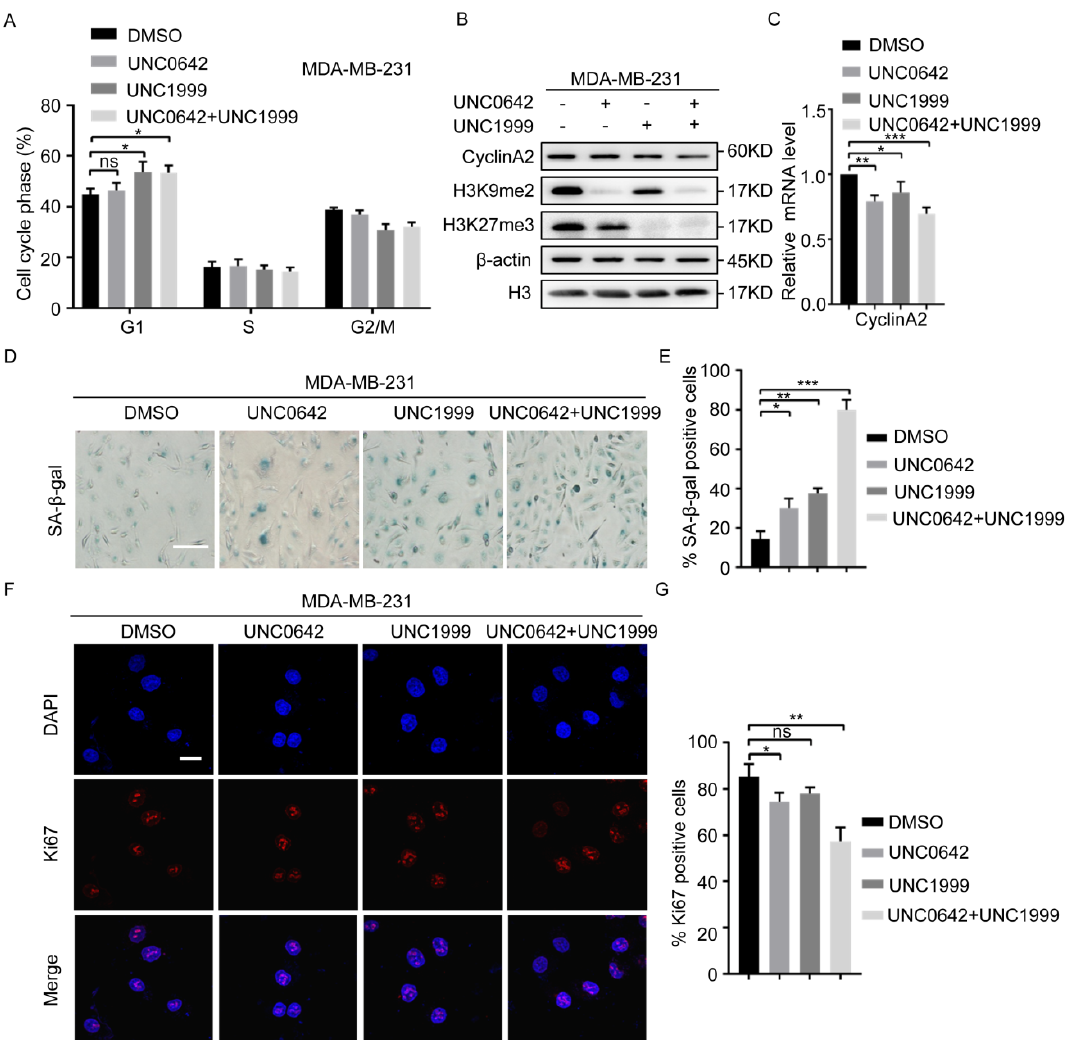
Figure 2. A combination of UNC0642 and UNC1999 induces MDA-MB-231 cellular senescence. ( A ) Cell cycle analysis in MDA-MB-231 cell treated with indicated treatments. ( B ) Western blot analysis of expression of CyclinA2, H3K9me2, and H3K27me3 in MDA-MB-231 cells treated with indicated treatments. ( C ) qRT-PCR analysis of the expression of CyclinA2 in MDA-MB-231 cells treated with indicated treatments. ( D , E ) SA- β -Gal staining in MDA-MB-231 cells treated with indicated treatments. Left panel represents images of SA- β -Gal ( D ), and right panel represents the statistical analysis of the percentage of SA- β -gal positive cells, scale bar: 100 nm ( E ). ( F , G ) Immunofluorescence analysis of Ki67 in MDA-MB-231 cells with the indicated treatments. Representative images of Ki67 positive cells were showed ( F ) and the percentage of the Ki67 positive cells was calculated, scale bar: 20 µm ( G ). Each experiment was repeated at least three times. Error bars, mean ± SD, ns: no significant, * p < 0.05, ** p < 0.01, *** p < 0.001.